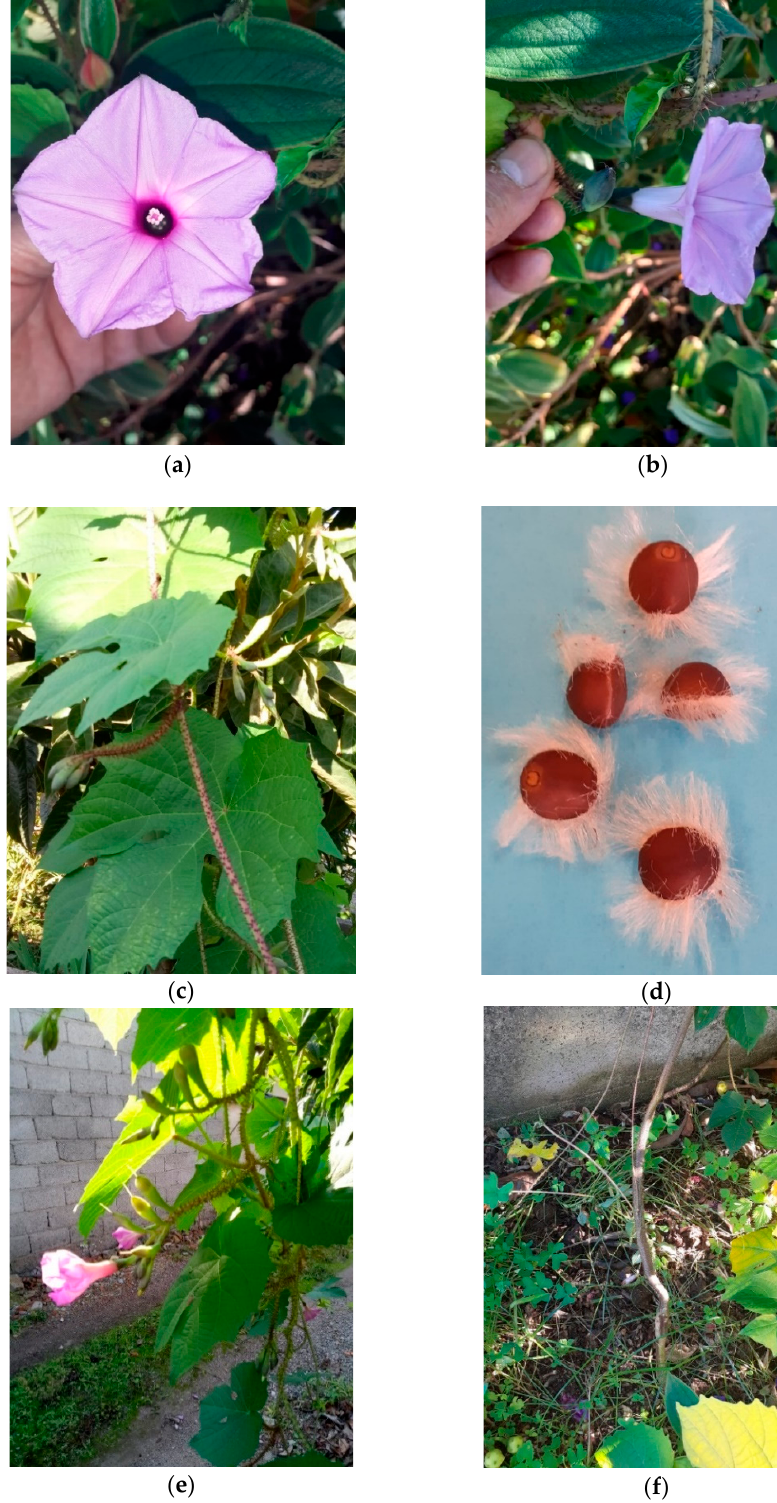
Figure A6. Ipomoea setosa Ker-Gawl. subsp. pavonii (Hallier f.) J.R.I. Wood & Scotland found for the first